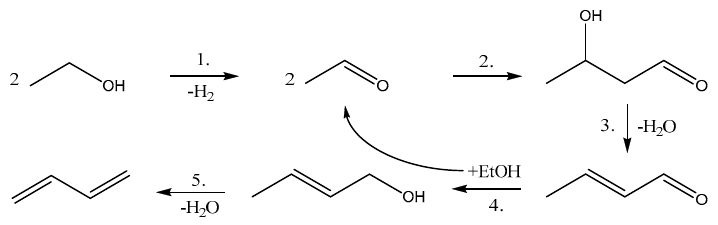
Figure 3. Generally accepted reaction pathway for the formation of butadiene from ethanol initially proposed by Kagan et al. [8].